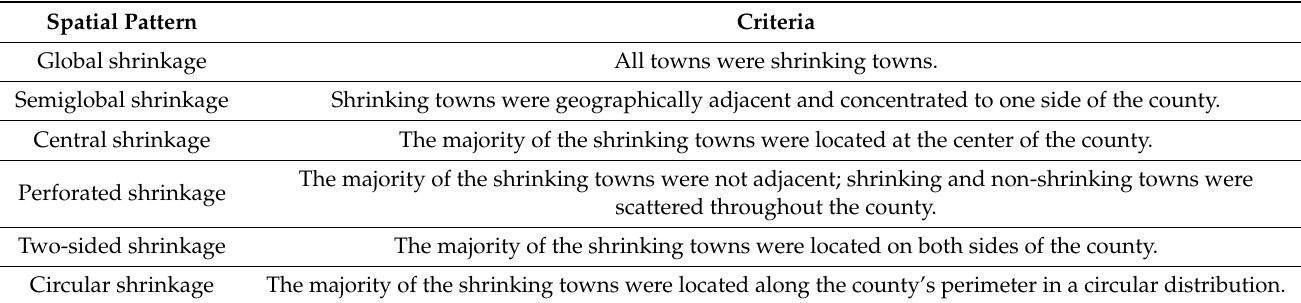
Table 5. Criteria for determining the spatial pattern of shrinking counties. Spatial Pattern Criteria Global shrinkage All towns were shrinking towns. Semiglobal shrinkage Shrinking towns were geographically adjacent and concentrated to one side of the county. Central shrinkage The majority of the shrinking towns were located at the center of the county. Perforated shrinkage Two-sided